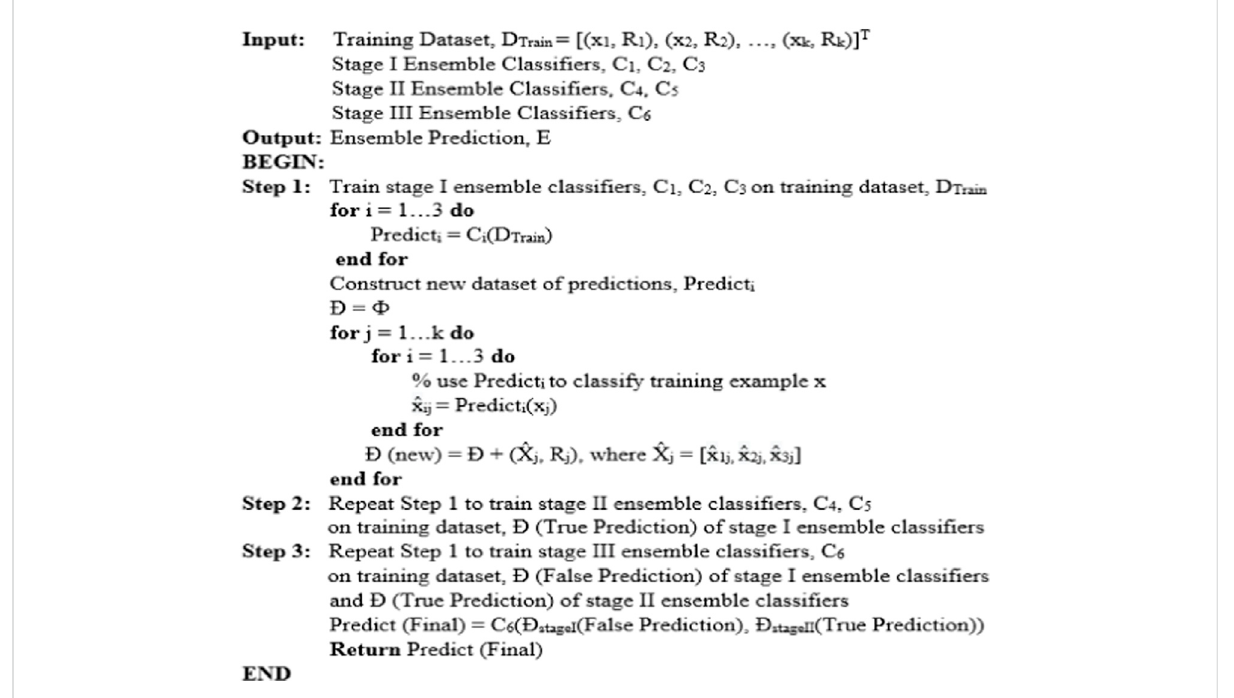
FIGURE 6 Pseudo code of the Proposed Ensemble